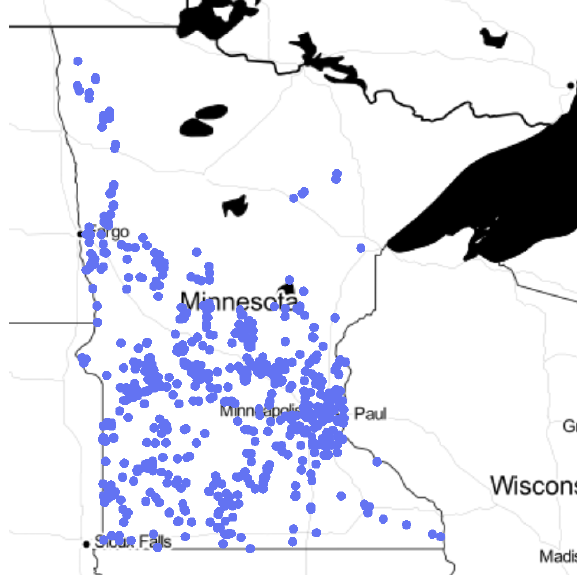
Figure 7. Distribution of ground-truth GWLA values for the state